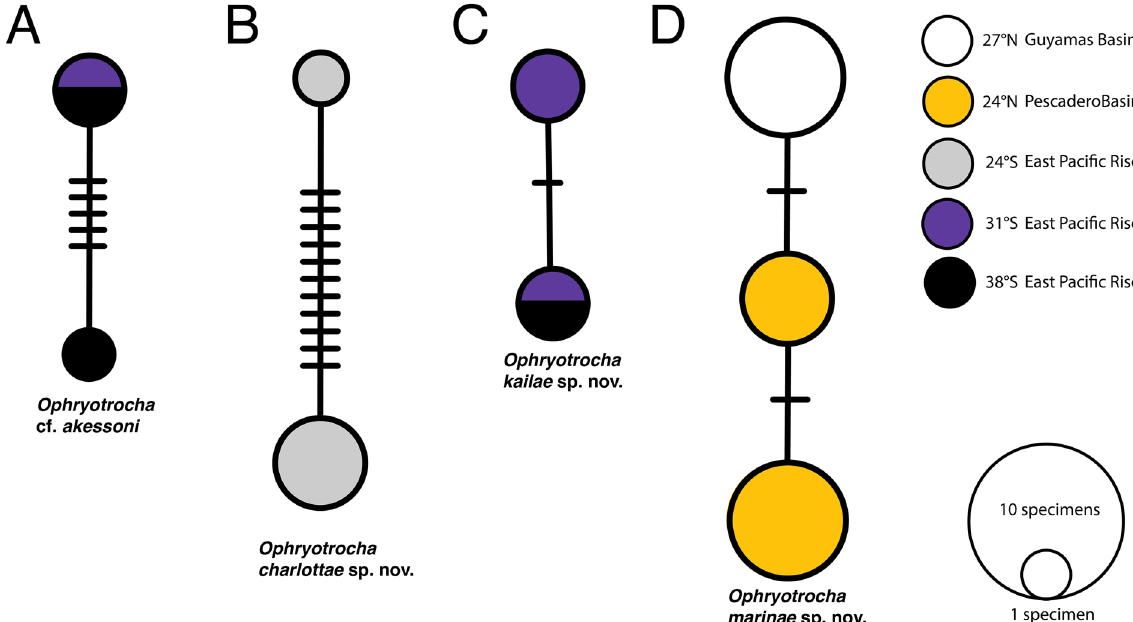
Fig. 2. Haplotype networks from COI data with geographic locality (°NS) coding. A . Ophryotrocha